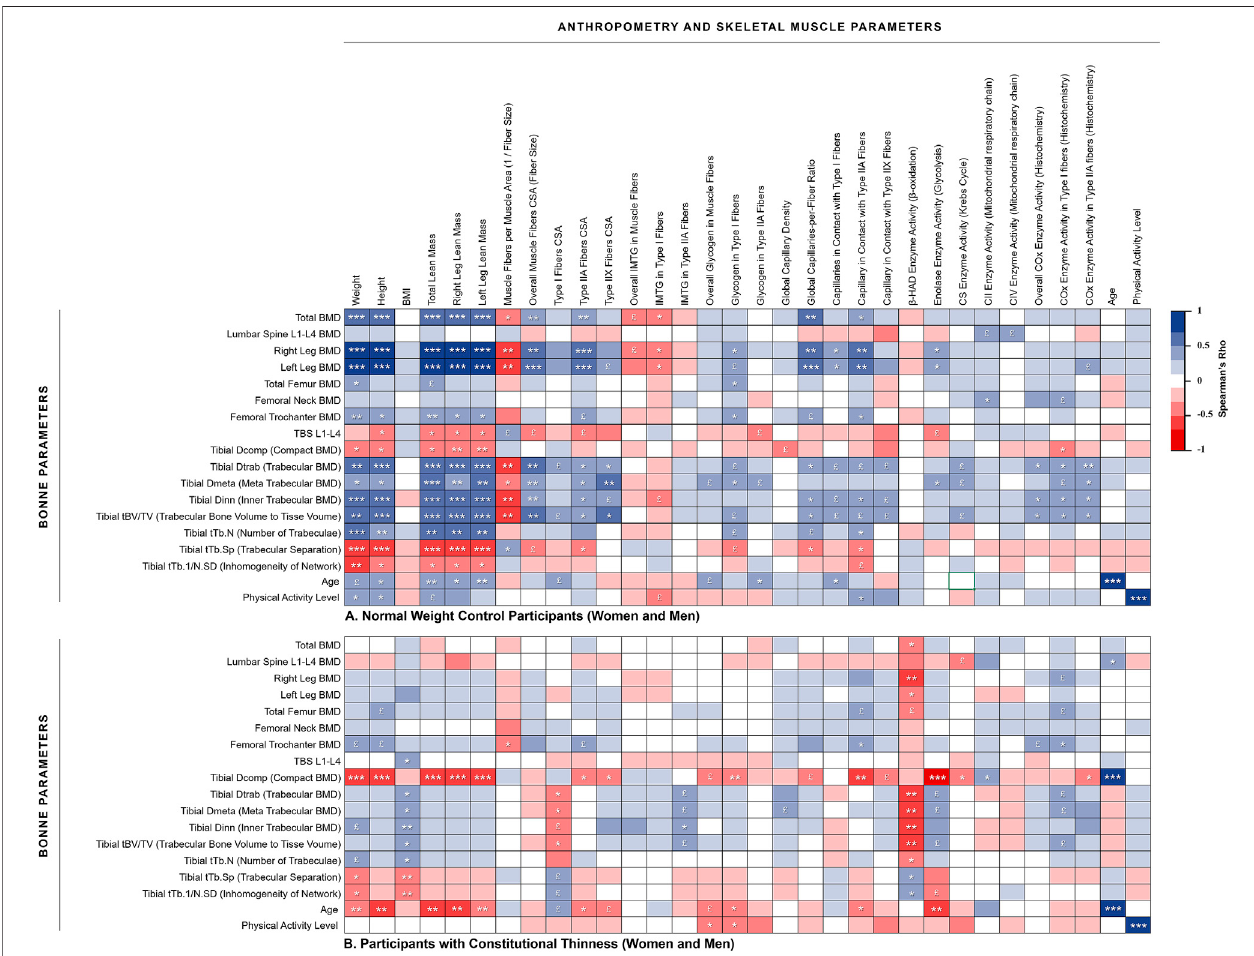
FIGURE 2 | Heat map of correlations between muscle and bone assessments. (A) Normal weight control participants (women and men); (B) Participants with constitutional thinness (women and men). * p < 0.05, ** p < 0.01, *** p < 0.001, £ 0.05 < p < 0.1 (trend). BMD, bone mineral density; BMI, body mass index; COx, cytochrome-c oxidase; CS, citrate synthase; CSA, cross-sectional area; IMTG, intramuscular triglycerides; TBS, trabecular bone score